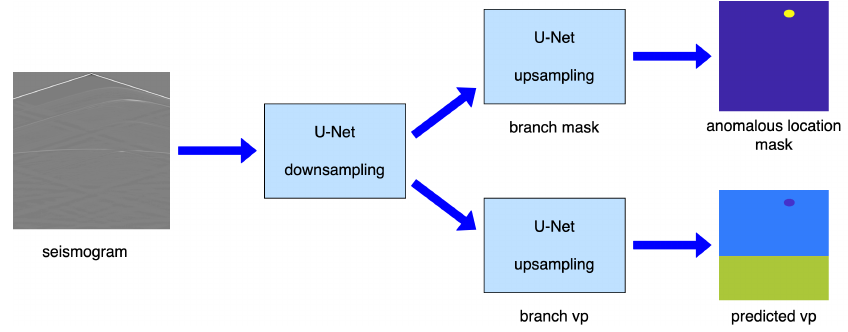
Figure 5. U-Net separated into 2